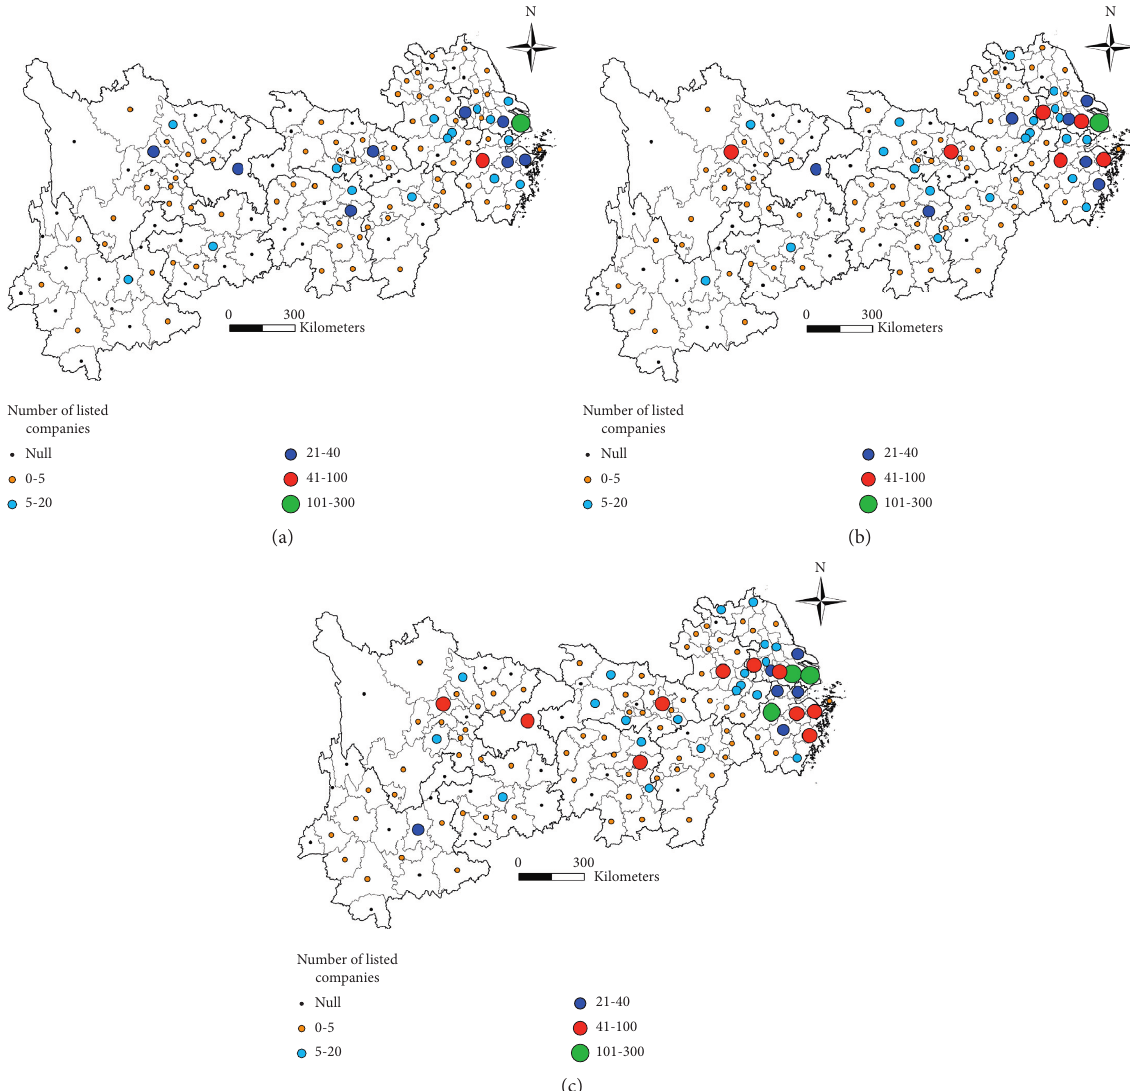
Figure 4: The distribution network of listed companies in cities of the YEB region in (a) 2008, (b) 2013, and (c) 2017.